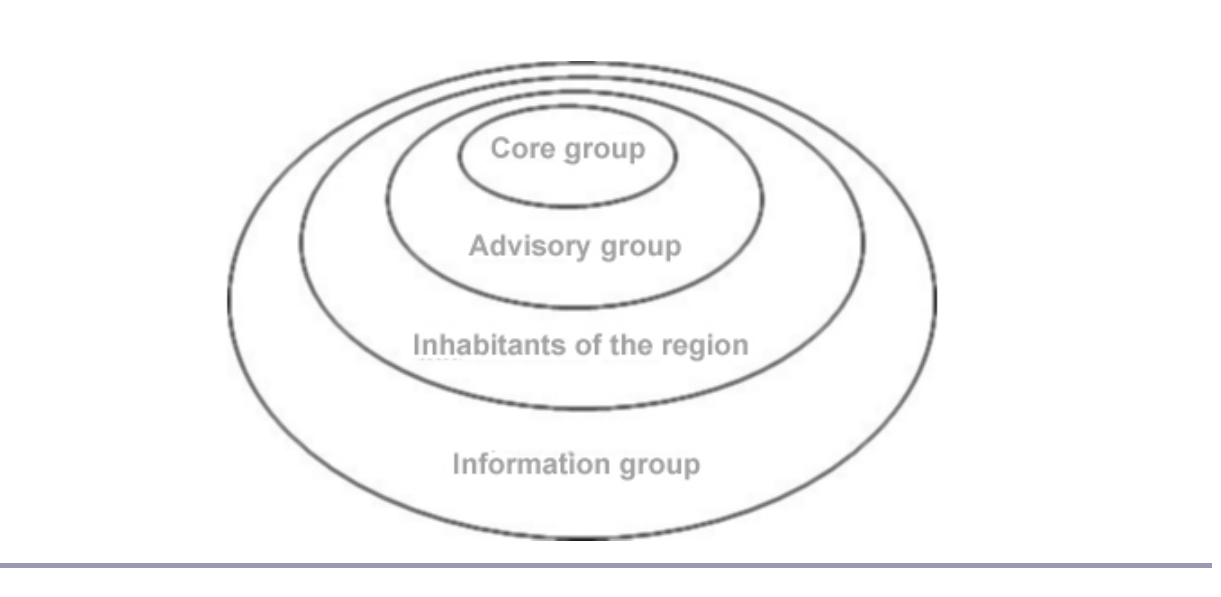
Fig. 1. Nested design of the Kromme Rijn participatory